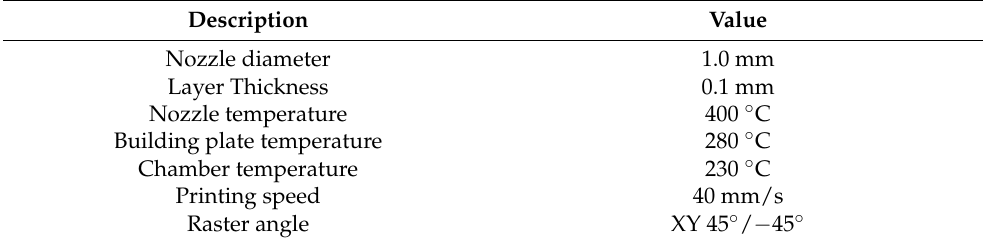
Figure 1. Dimensions of 3D printing sample of PEEK/HA composites in accordance with ASTM D638 Type 4 specimens. Table 1. The 3D Printing